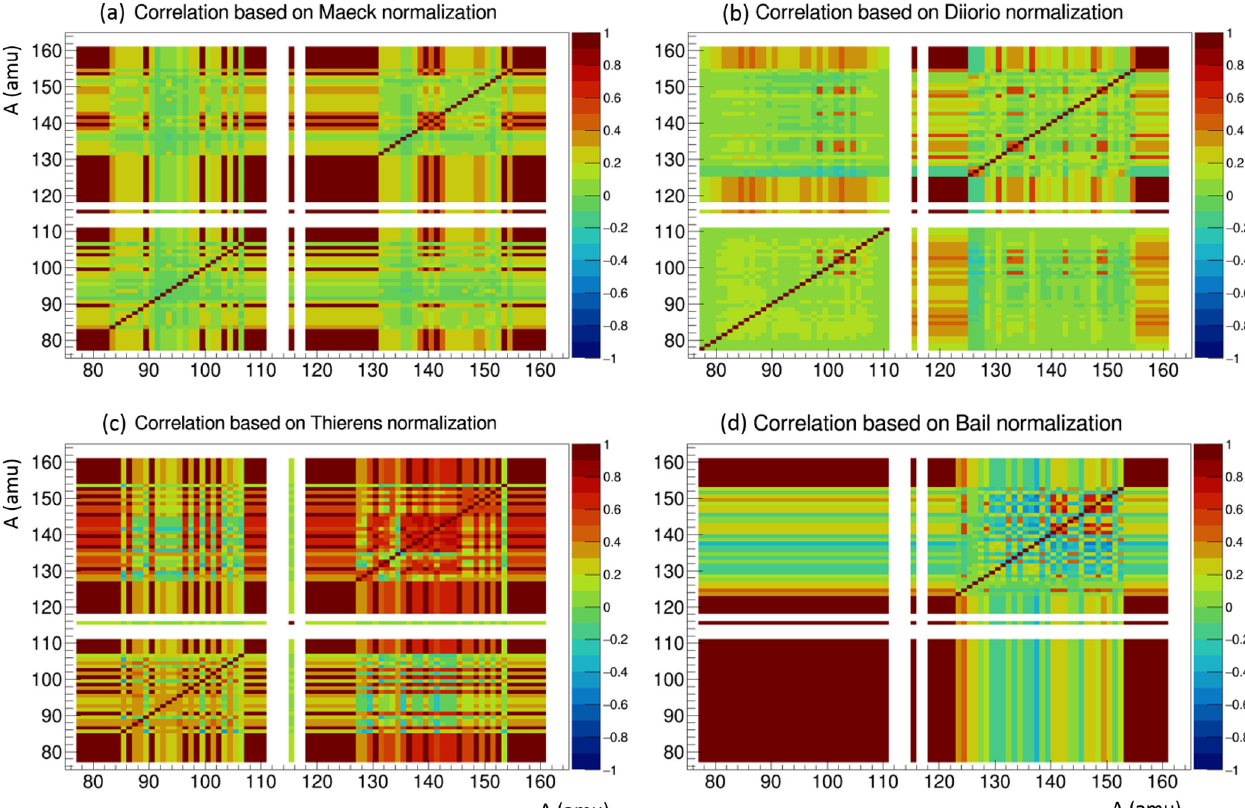
Fig. 6. For each evaluation, the correlation matrix is represented as a function of mass. Results present some large discrepancies as a function of the reference data set used for the cross-normalization of data